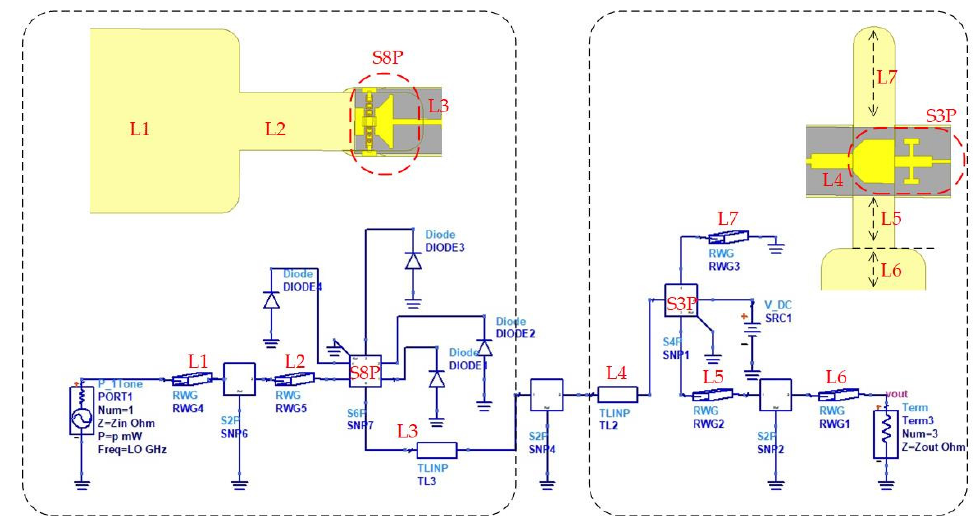
Figure 4. Design of the 200 GHz monolithic integrated doubler based on the field-circuit method (L1 = 0.7 mm, L2 = 0.57 mm, L3 = 0.1 mm, L4 = 0.22 mm, L5 = 0.27 mm, L6 = 0.15 mm, and L7 = 0.52 mm).